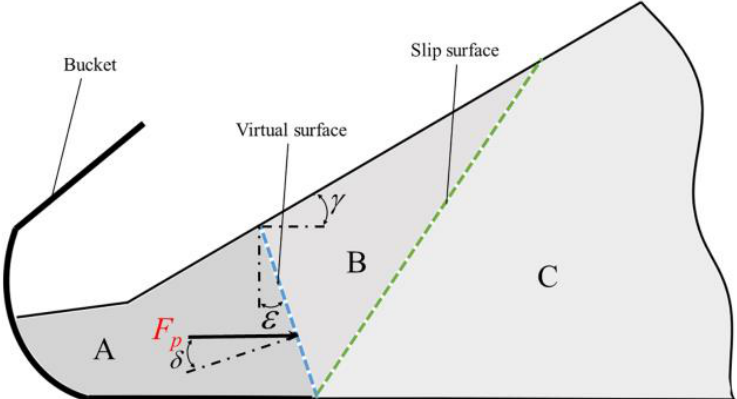
Figure 9. Schematic diagram of virtual surface and slip surface.